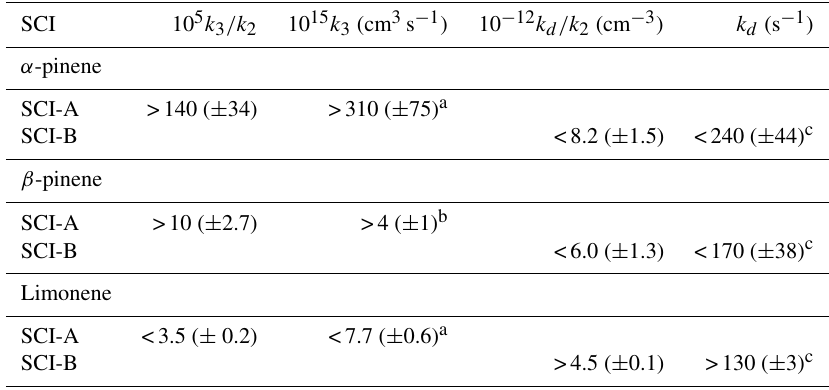
Table 2. Monoterpene-derived SCI relative and absolute a rate constants derived in this work. SCI